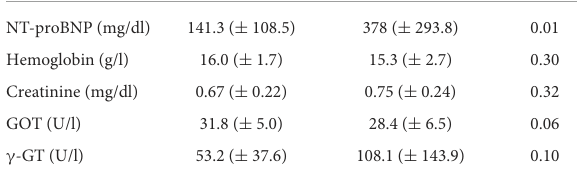
TABLE 2 Mean anthropometric measurements for the two groups with standard deviation in brackets and the p -value for the t -test between the two groups.